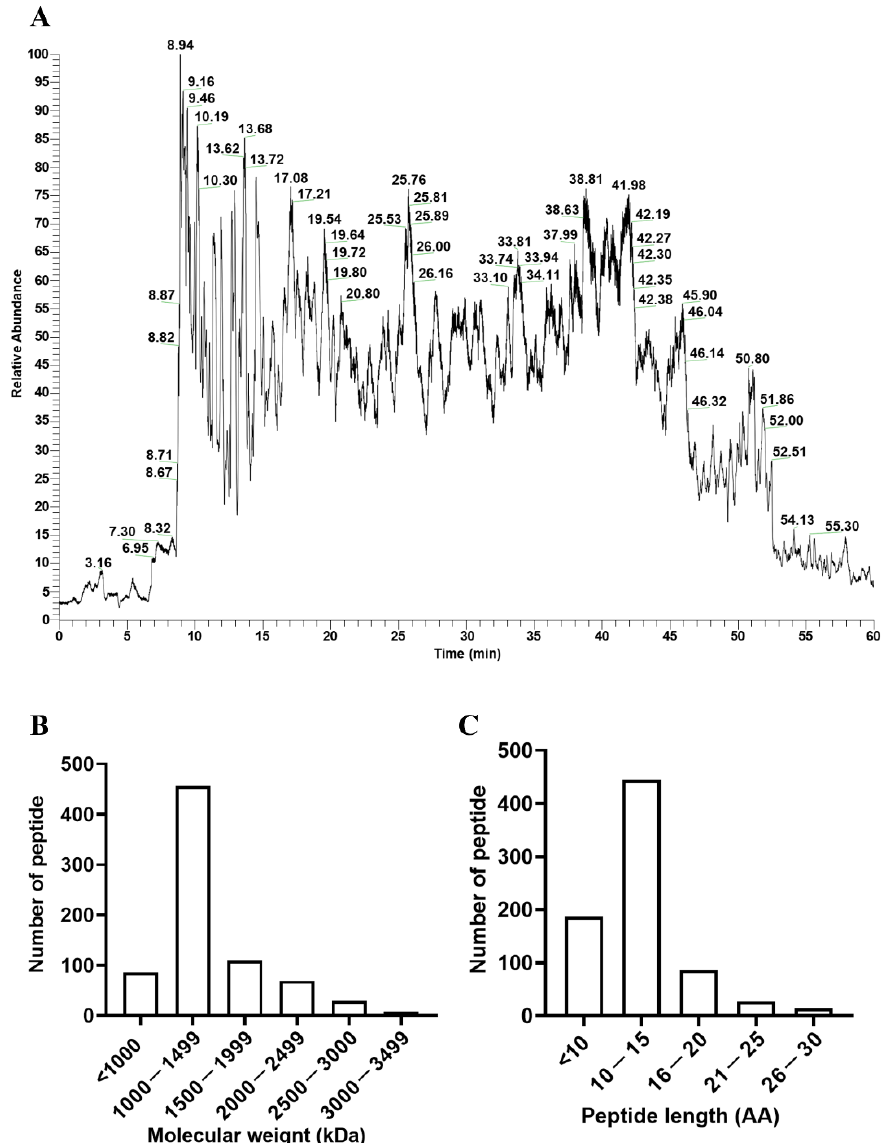
Figure 1. Characteristics of the PPH peptide profile. ( A ) The peptides in PPH were characterized using LC-MS/MS. ( B ) Molecular weight distribution of the identified peptides. ( C ) Peptide length distribution of the identified peptides.